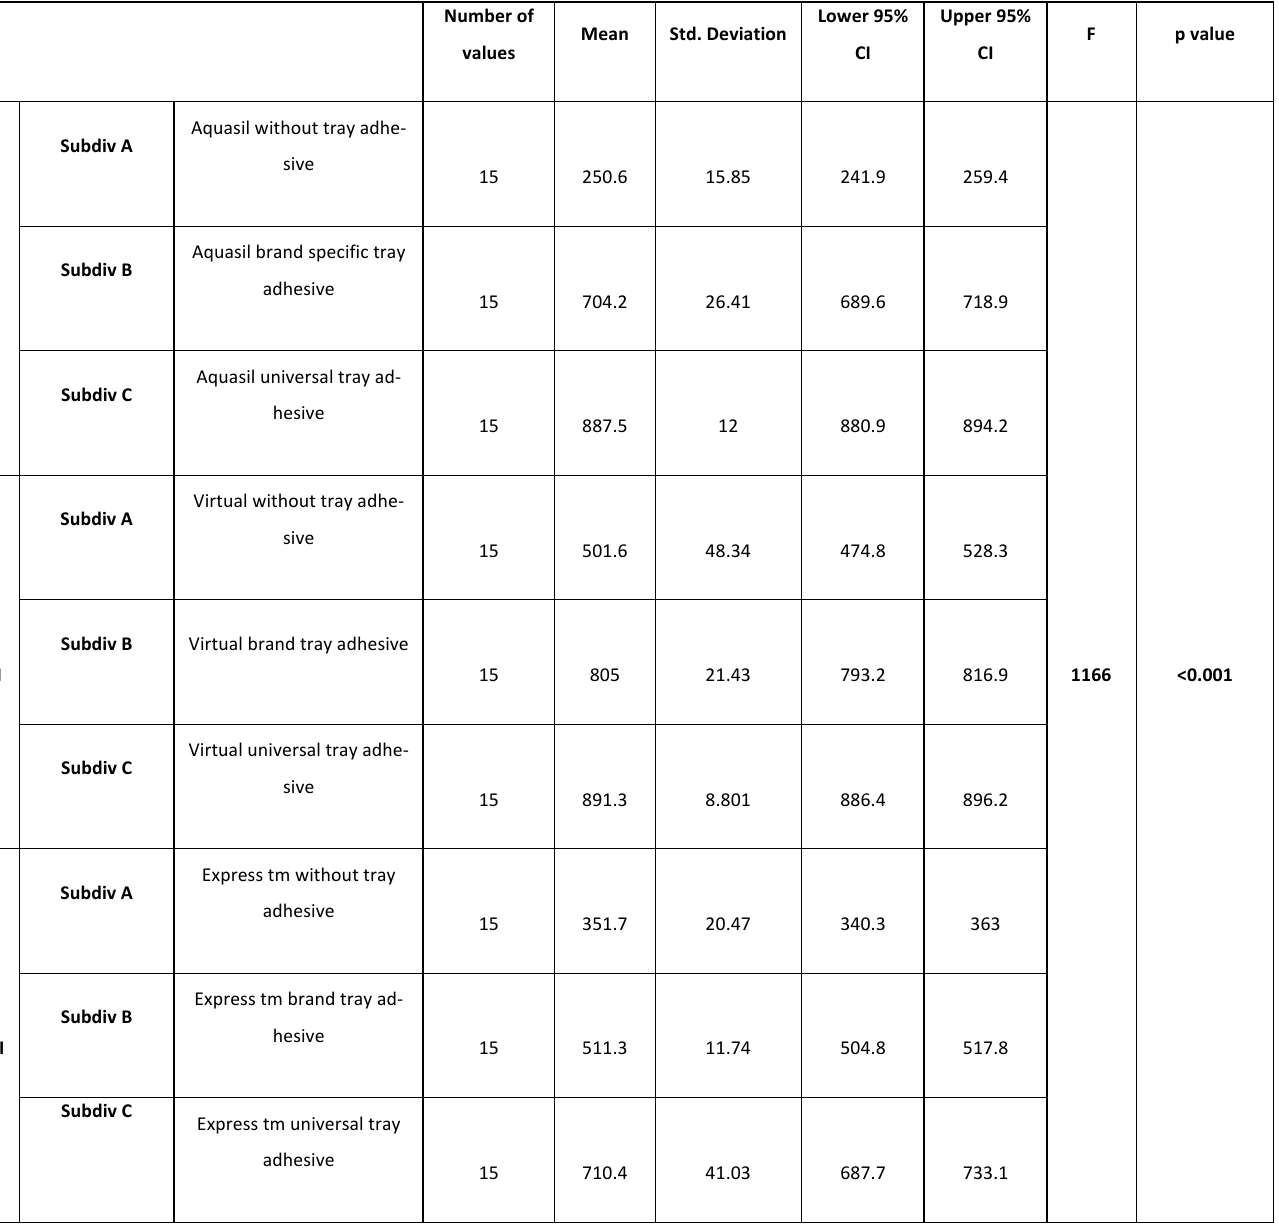
Table 5. One way anova test to compare the reten6ve strength of the